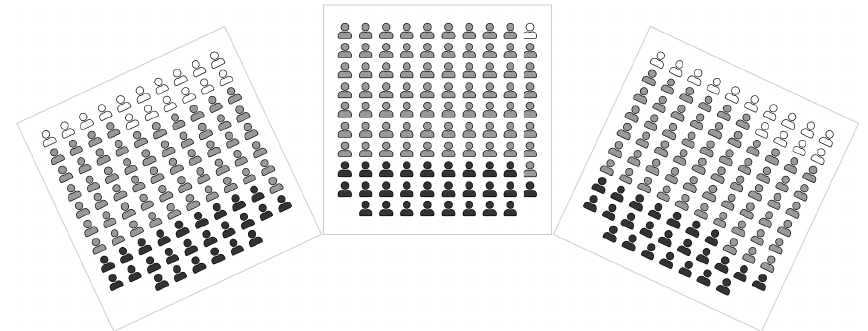
Fig. 5. Mockup of the live overview when teams are assigned parts of a lecture hall with each student being represented by an icon. White icons represent students who are not logged in, light grey icons represent students who are logged in but have not yet an- swered, and dark grey icons represent students who have